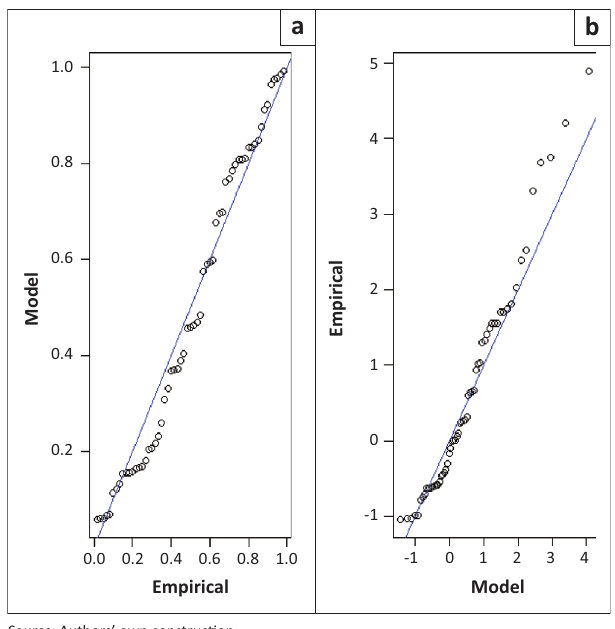
FIGURE 5: Diagnostic plots for the time-heterogeneous generalised extreme value model with a trend in both the location and scale parameters at Sicacate hydrometric station: (a) Residual probability plot; (b) Residual quantile